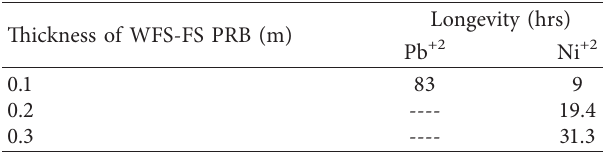
----: run time equal to